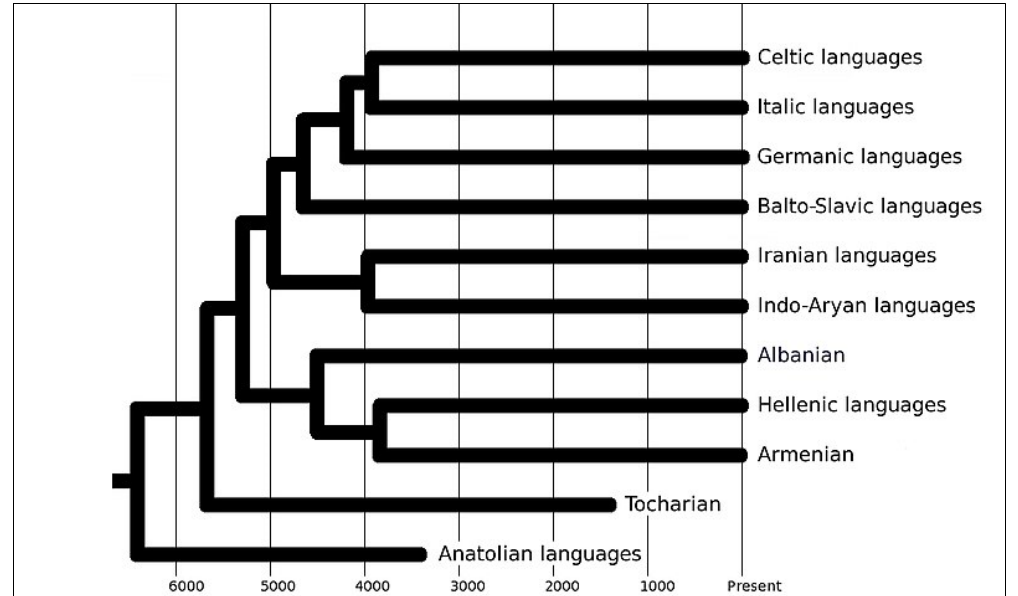
Figure 1. Indo-European language family relations chart (‘Ancestry-constrained phylogenetic analysis of Indo-European languages’ by Ordinary Person 2020/Wikimedia Commons is released under CC BY-SA 4.0).